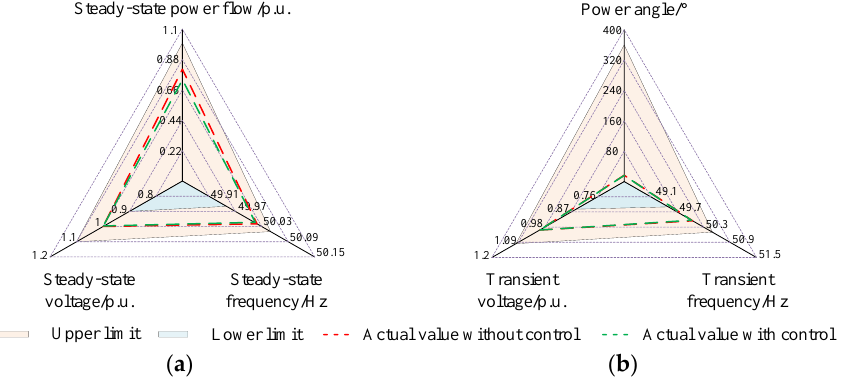
Figure 14. Static and dynamic security indices of region B. ( a ) Static indices; ( b ) Dynamic indices corresponding to the maximum transient frequency and voltage.